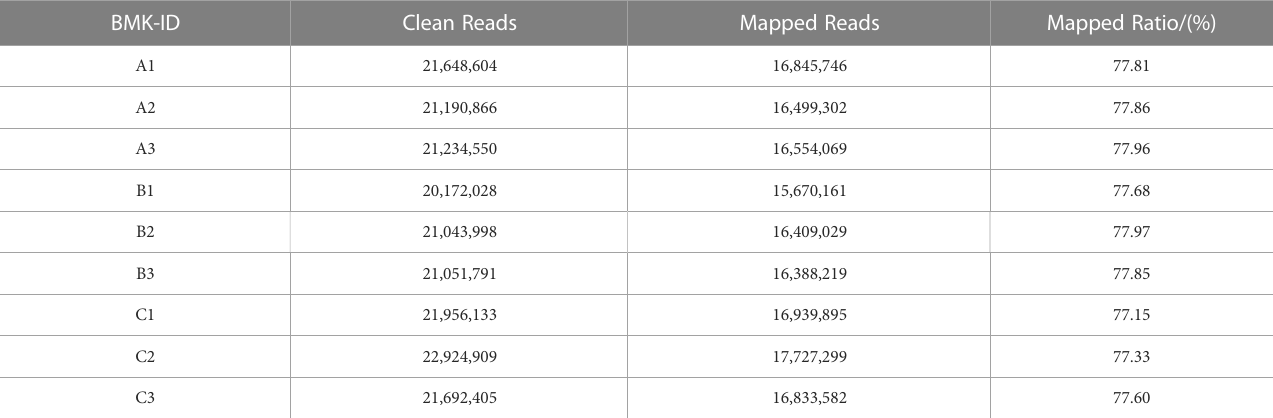
TABLE 5 Comparison of sequencing data and assembly results. BMK-ID Clean Reads Mapped Reads